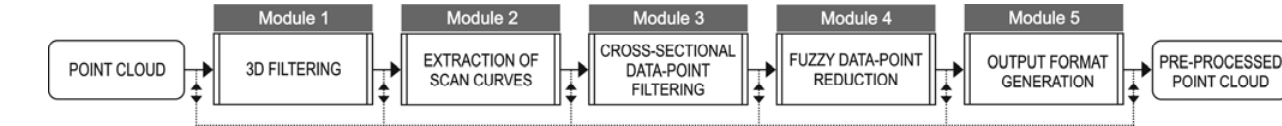
Figure 1. General model of the SyPreF